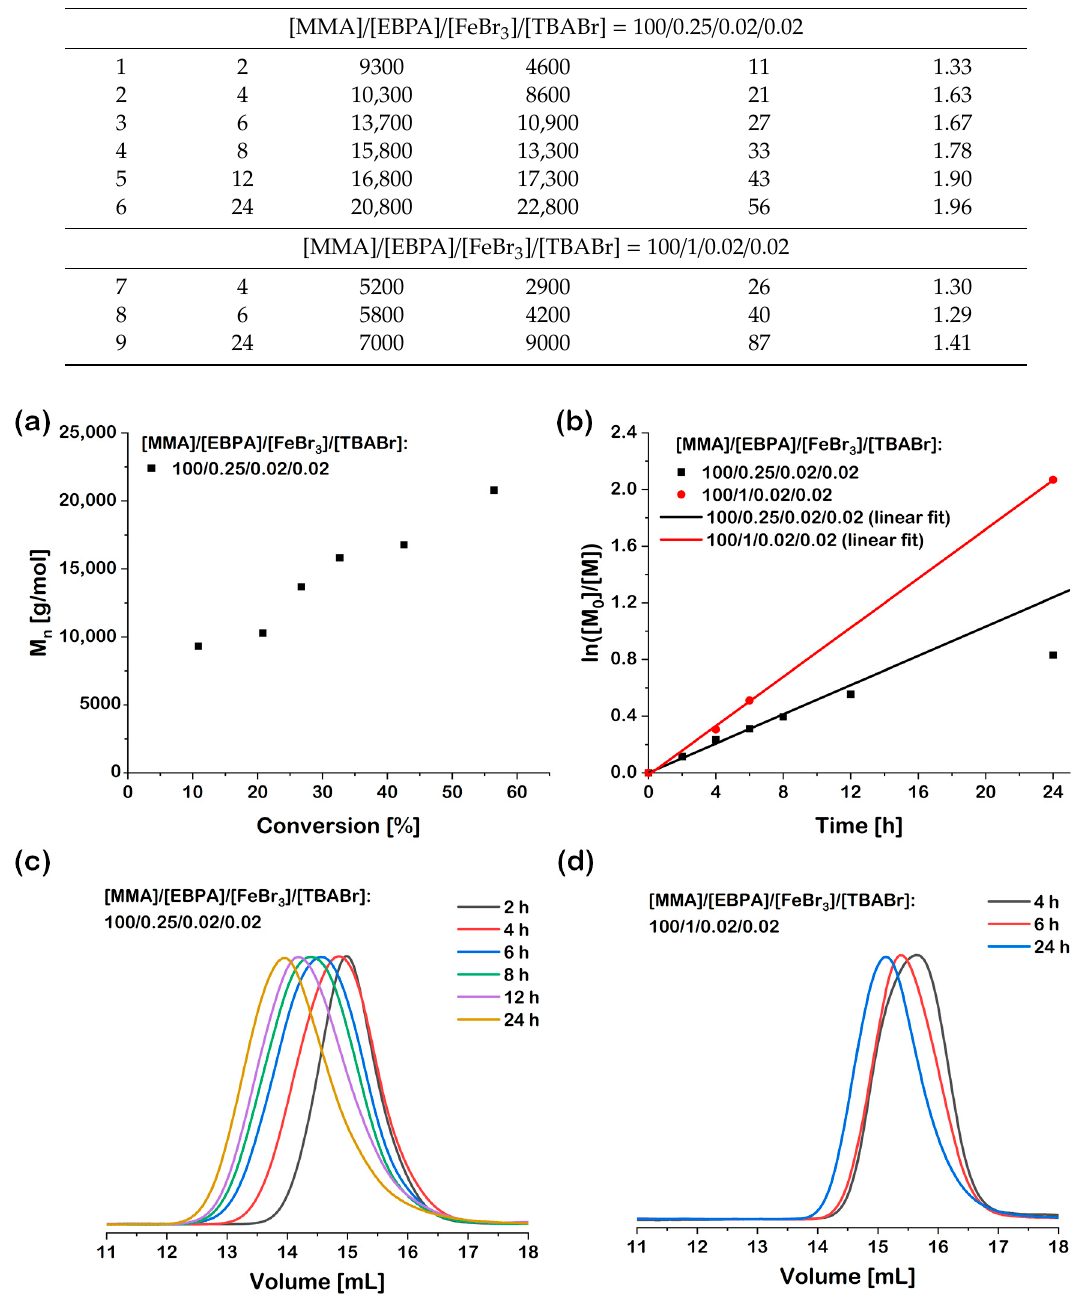
Figure 4. Results of syntheses of PMMA polymers in the solution by means of photo-Fe-ATRP: ( a ) number-average molecular weight (Mn) vs. conversion, ( b ) semilogarithmic kinetic plots, ( c , d ) gel permeation chromatography (GPC)